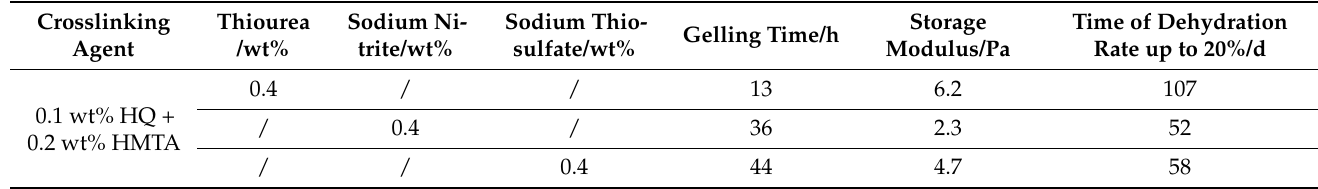
Table 3. Effect of deoxidizer type on gel properties.